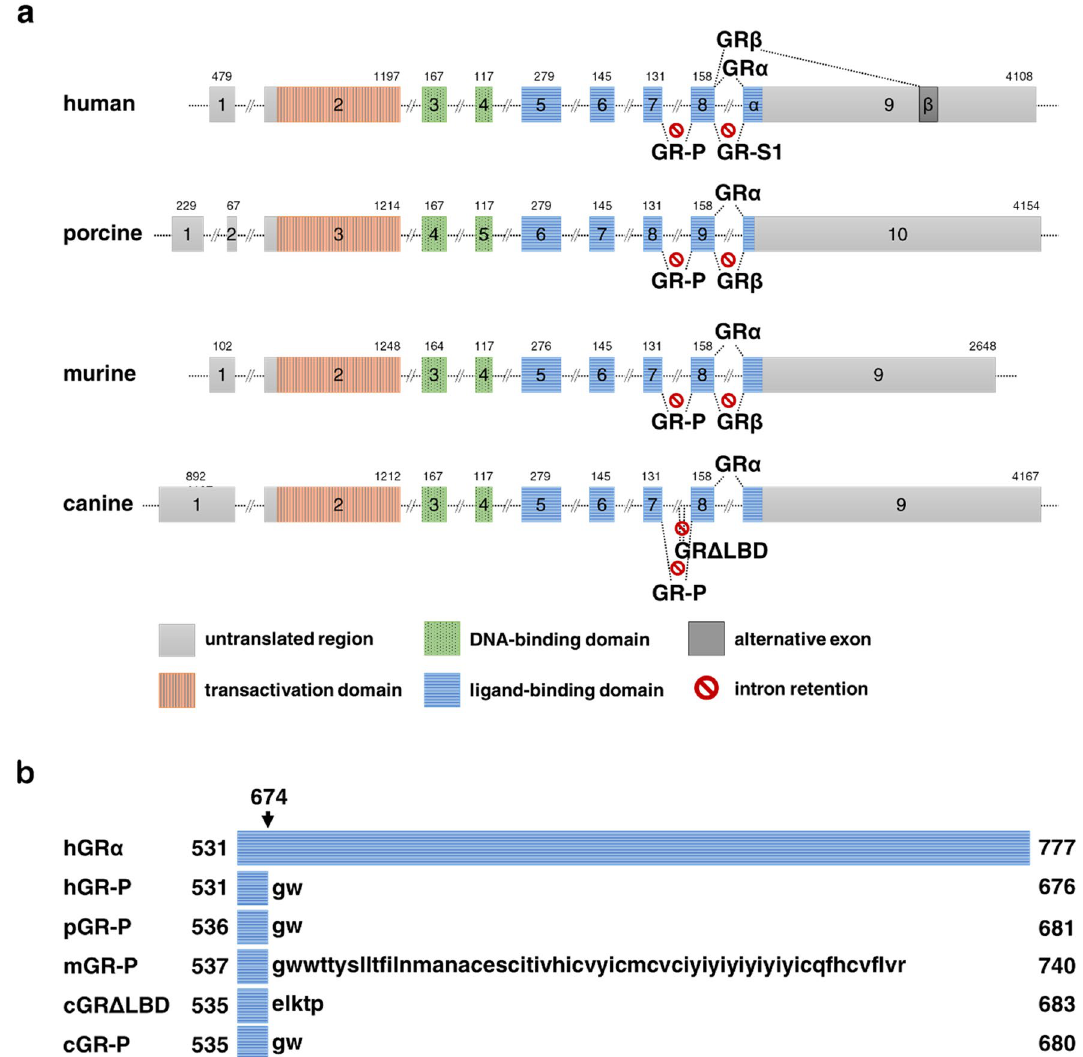
Figure 1. Schematic of the main 3’ end splice variants in human (h), porcine (p), murine (m) and canine (c) NR3C1 gene and protein alignment of GR-P isoform of various species. (a) The main 3’ end splice variants of the human, porcine, murine and canine glucocorticoid receptor transcripts. Untranslated regions are marked by light grey boxes and the amino acid coding exons are coloured according to the encoded GR protein domains (i.e., orange: transactivation domain, green: DNA-binding domain, blue: ligand-binding domain, dark grey: alternative exon encoded amino acids). (b) Protein sequence alignment of the ligand-binding domain of GR-P isoform of different